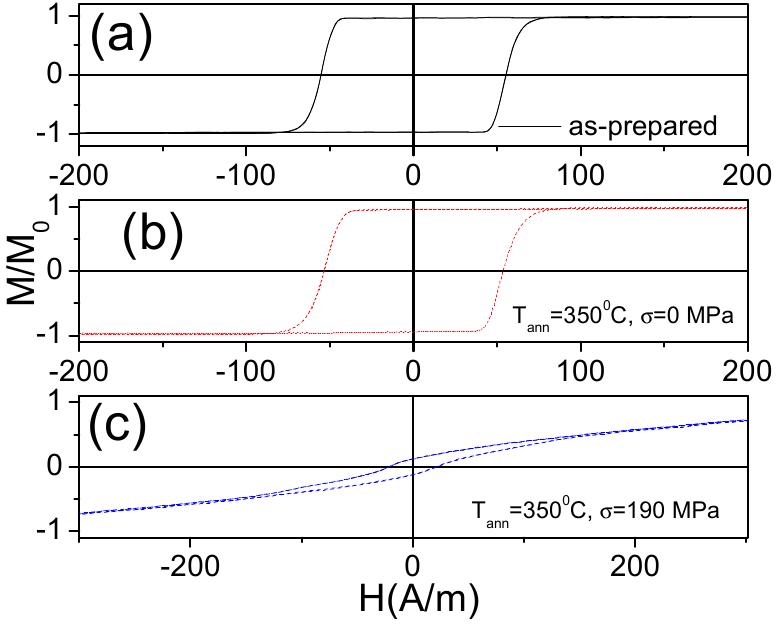
Figure 1. Hysteresis loops of as-prepared ( a ); annealed at T ann = 350 ◦ C for σ a = 0 MPa ( b ), and at T ann = 350 ◦ C for σ = 190 MPa ( c ) Fe 75 B 9 Si 12 C 4